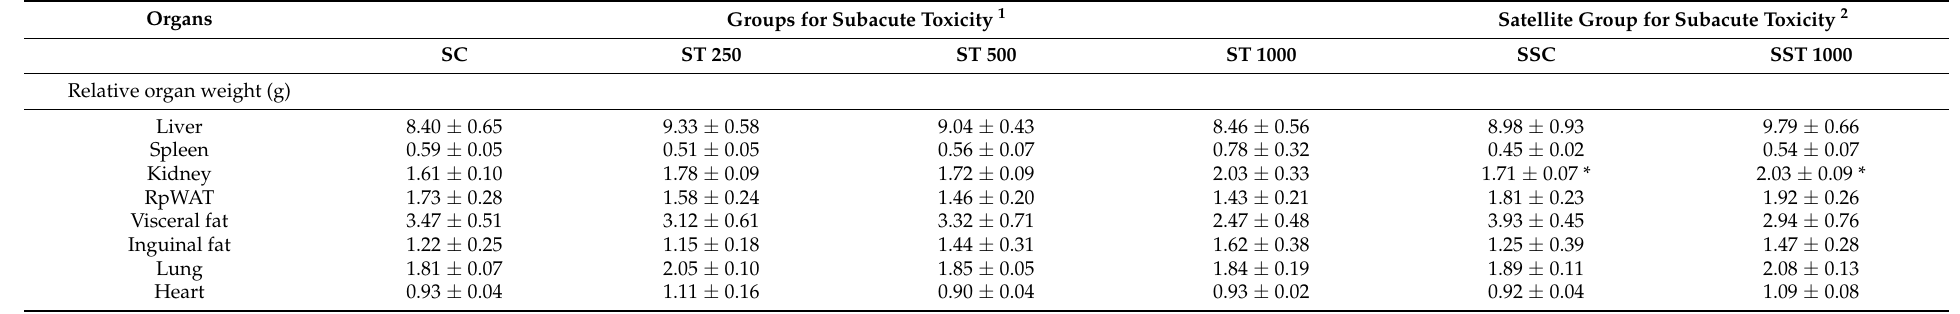
Table 9. Relative organ weight of rats treated with E. tapos yoghurt in the subacute toxicity study. Values are expressed as mean ± SEM. (*) indicates a significant difference at p <